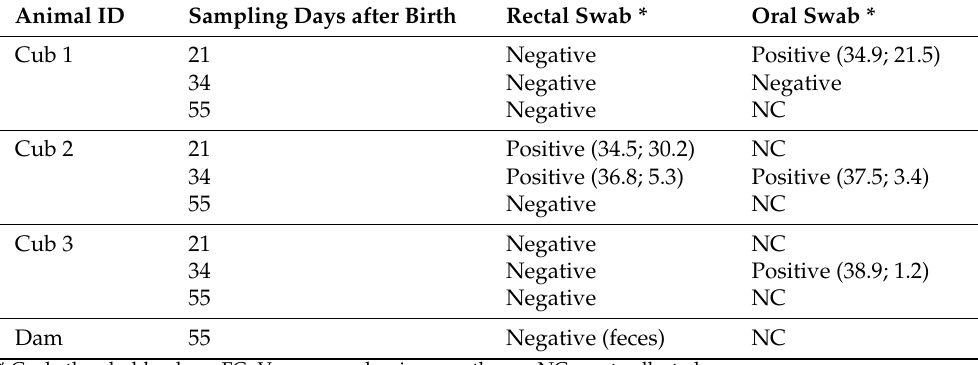
Table 4. RT-qPCR results in tiger cubs and dam samples.